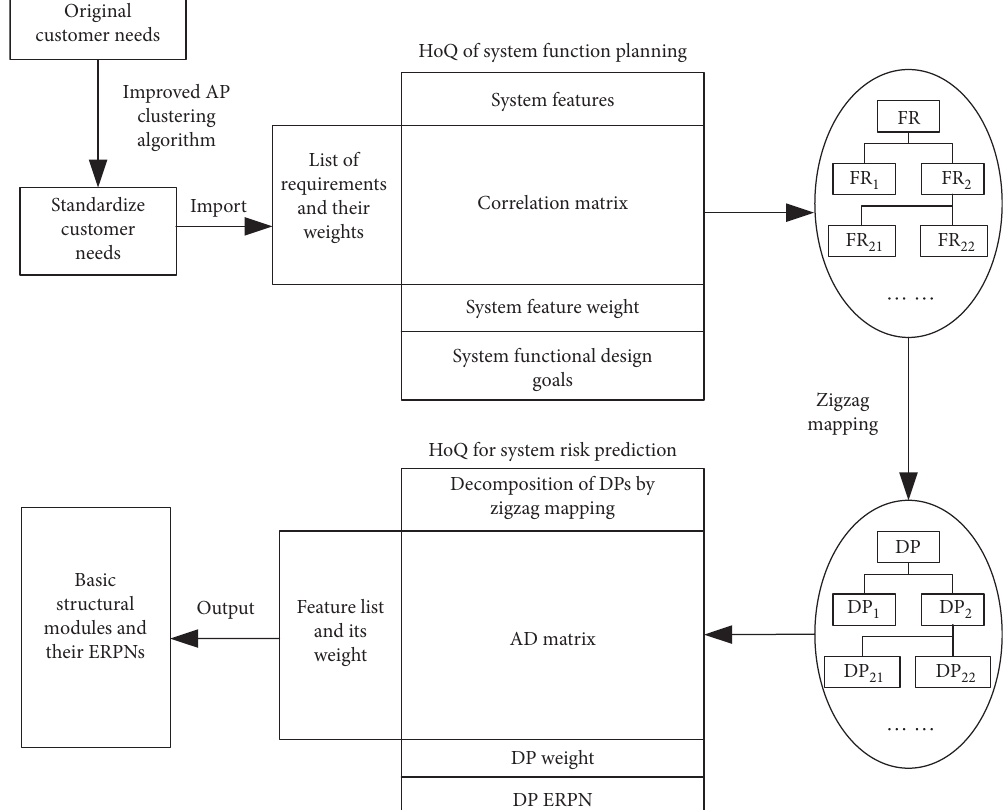
Figure 1: Design model integrating AP/QFD/AD, with functional requirements (FR), design parameters (DPs), and extended risk priority numbers